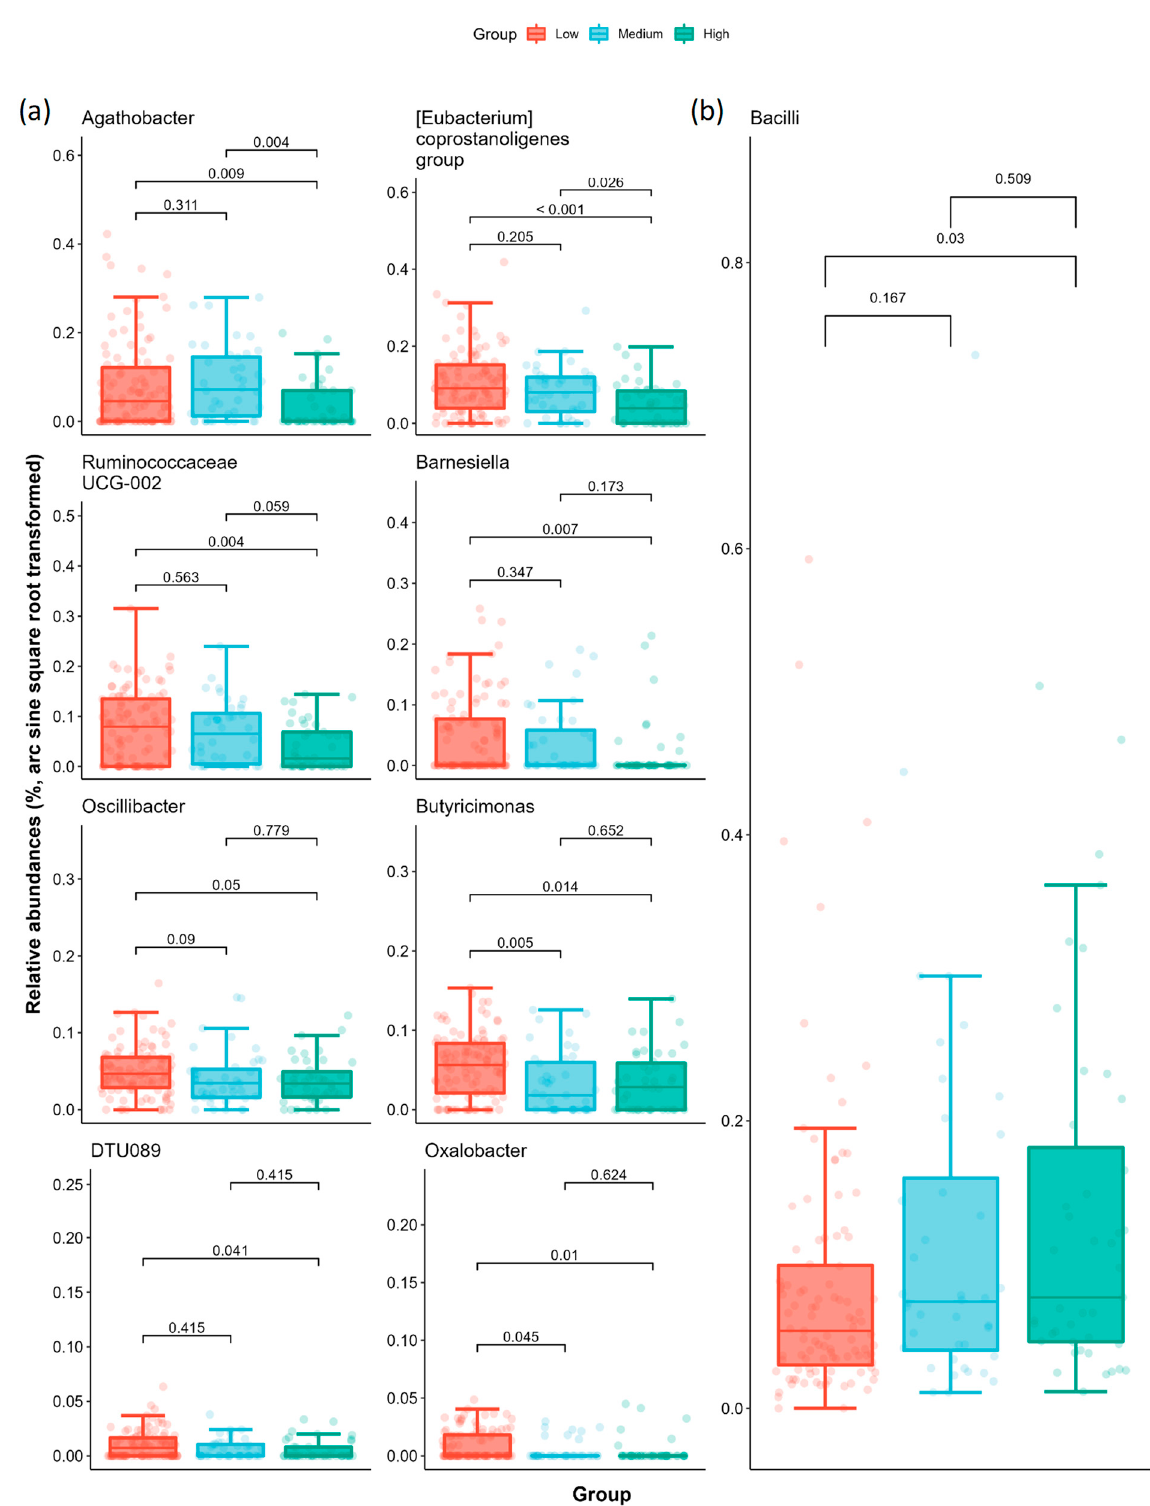
Figure 3. Relative abundances of significantly differed taxa among low, medium, and high AoAc groups: ( a ) genus and ( b ) class level. The center lines in boxes represent the medians; box limits indicate the 25th and 75th percentiles; and whiskers extend 1.5 times the interquartile range from the 25th and 75th percentiles. The p values for pairwise comparisons using pairwise Dunn’s test with Holm’s correction are shown on each pair of